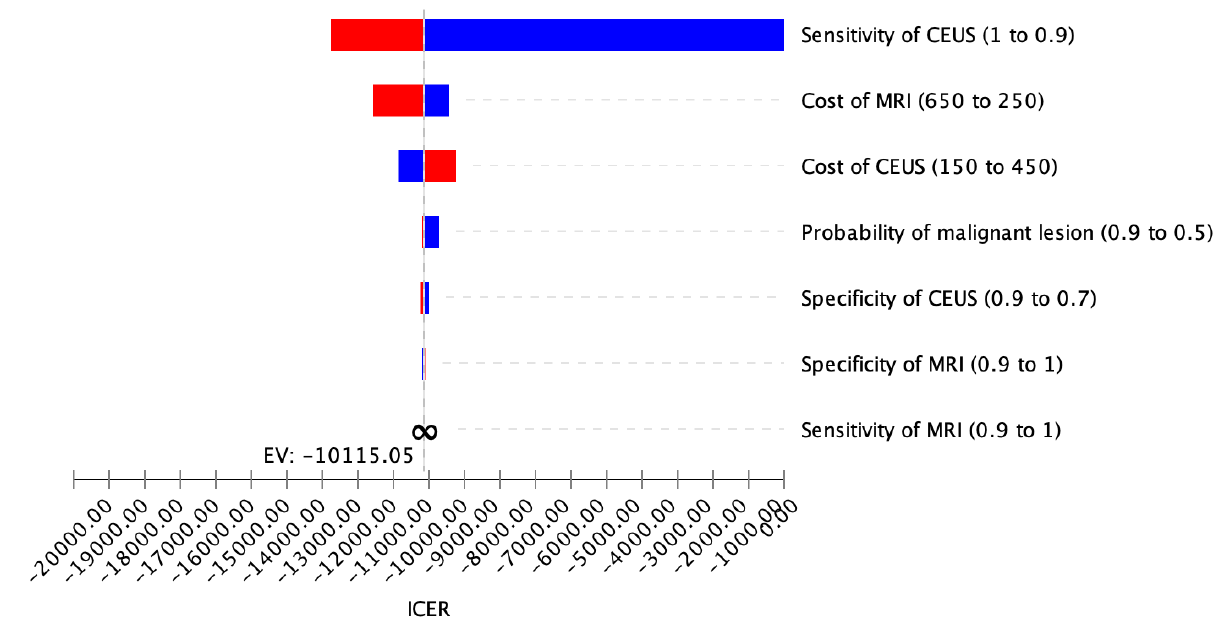
Figure 2. Deterministic sensitivity analysis. The displayed tornado diagram demonstrates the influence of changing values on ICER in the reference case. The ICER of CEUS remained beneath the WTP boundary of USD 100,000 per QALY for every analyzed parameter range, proving the cost-effectiveness of CEUS in the base-case setting.